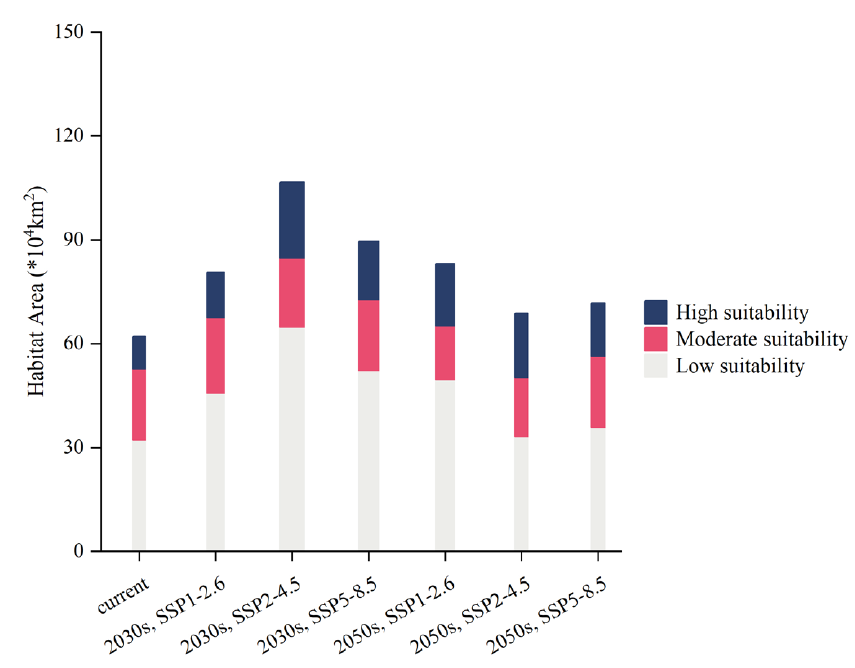
Figure 6. Areas of suitable habitats of Tagetes minuta currently and in the future under different pathways (SSP1-2.6; SSP2-4.5; SSP5-8.5). During the 2030s, under SSP2-4.5, the high-suitability habitat area of T. minuta was predicted to be 2.27 × 10 4 km 2 , the moderate-suitability habitat area was predicted to be 20.15 × 10 4 km 2 , and the total habitat area was predicted to be 87.09 × 10 4 km 2 , accounting for 2.27%, 2.1%, and 6.74% of China, respectively. During the 2050s, under SSP2-4.5, the